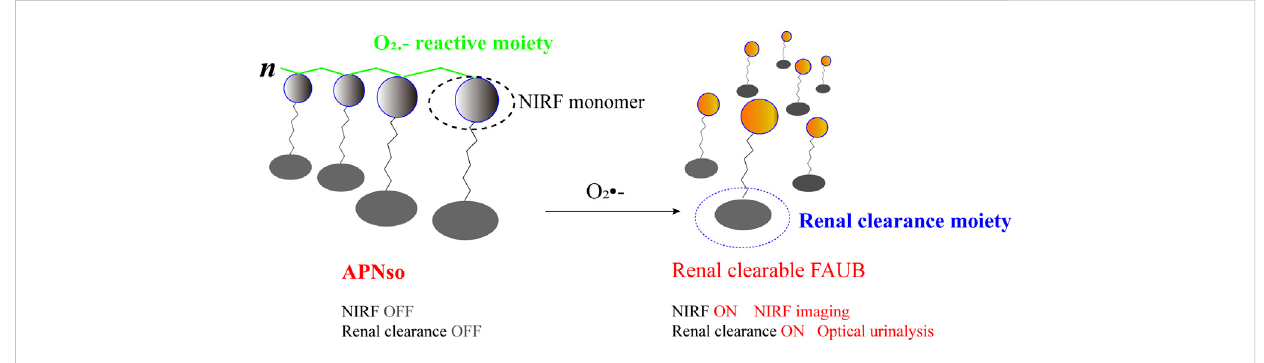
FIGURE 2 Schematic representation of the APN SO probe for HIRI NIRF imaging and urine